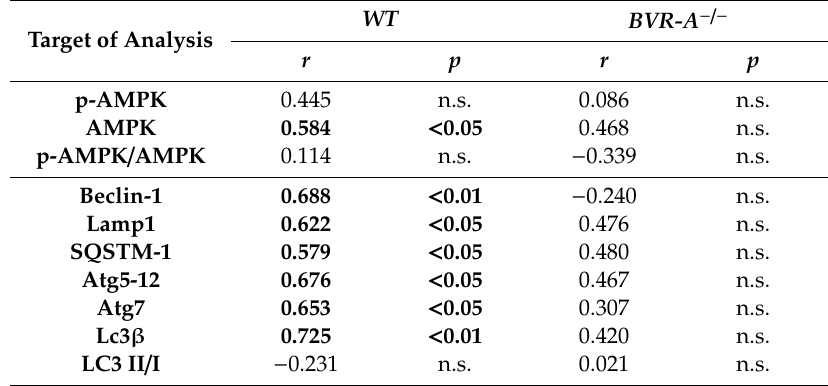
Table 2. Correlation analysis between p-mTOR (Ser2448) and proteins involved in autophagy pathway. Significant values are in